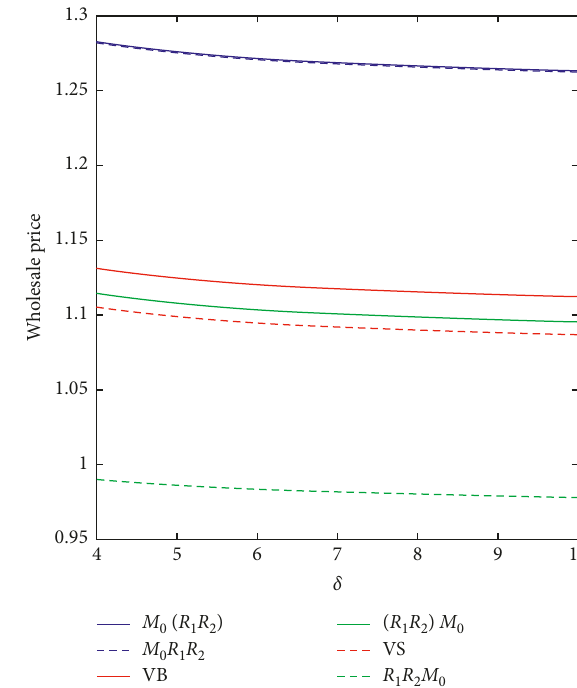
Figure 5: Effect of δ on the product greenness in centralized and decentralized models.